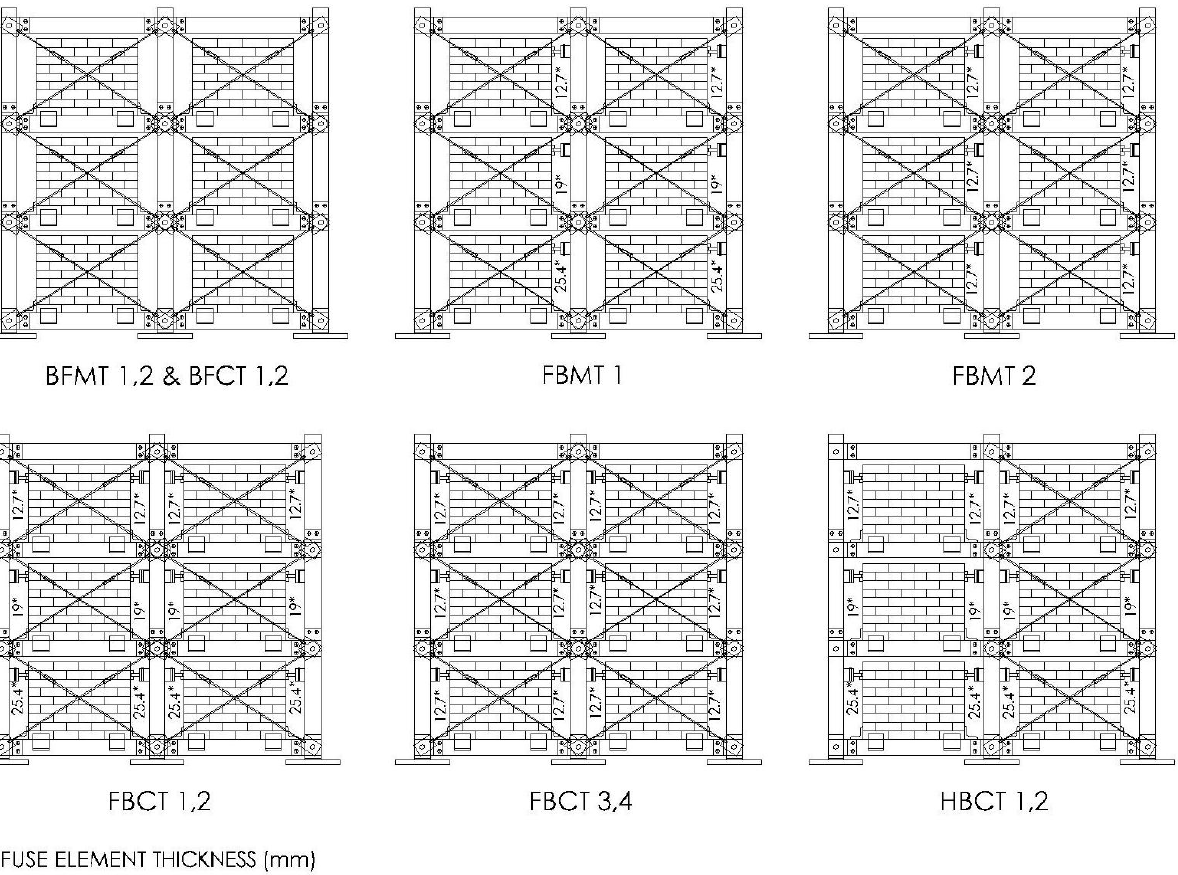
Figure 6. Test frame configurations for cyclic test program.